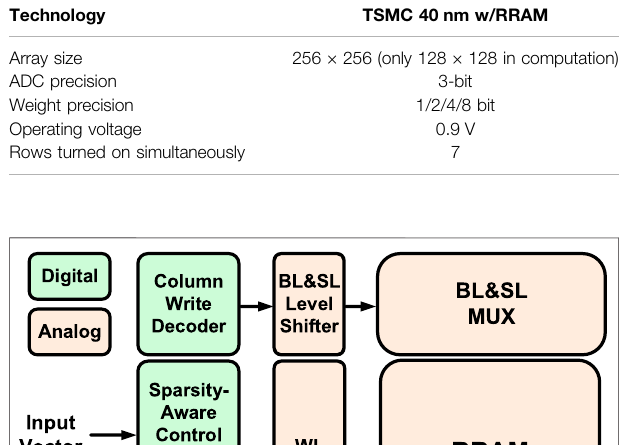
TABLE 2 | Table of simulator settings. Technology